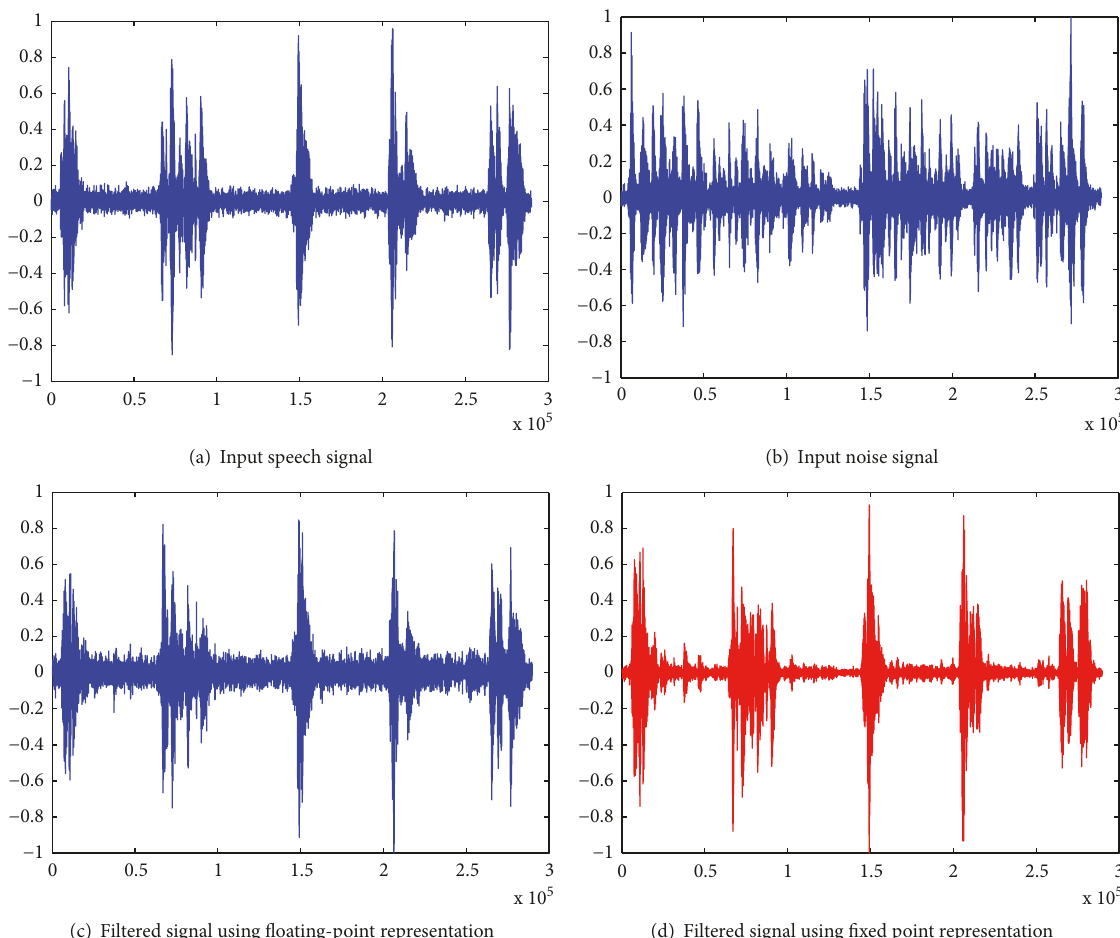
Figure 7: Input signal and results of BSS.